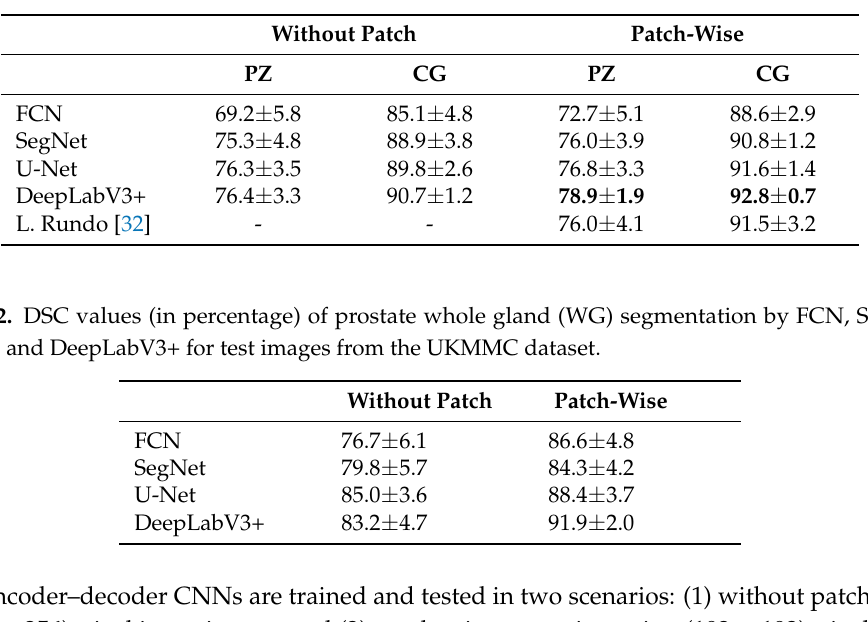
Table 1. DSC values (in percentage) of prostate peripheral zone (PZ) and central gland (CG) segmentation by FCN, SegNet, U-Net, and DeepLabV3+ for test images from the NCI-ISBI 2013 dataset.